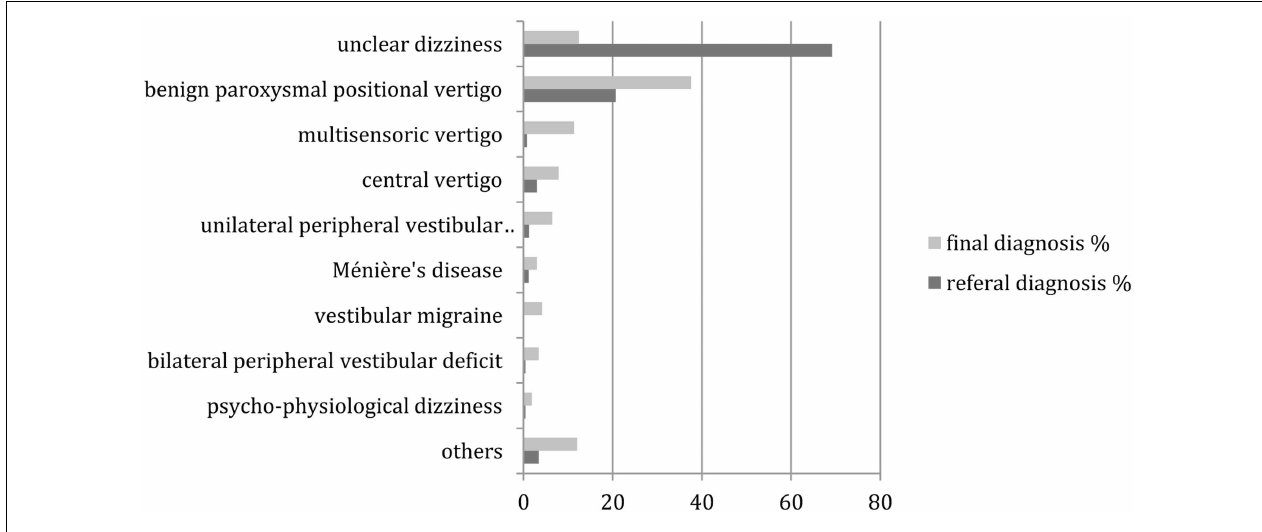
paroxysmia, acoustic neuroma, canal dehiscence syndrome, mal de débarquement, ototoxicity, dizziness after cervical spine distorsion, vertigo in cervical pain